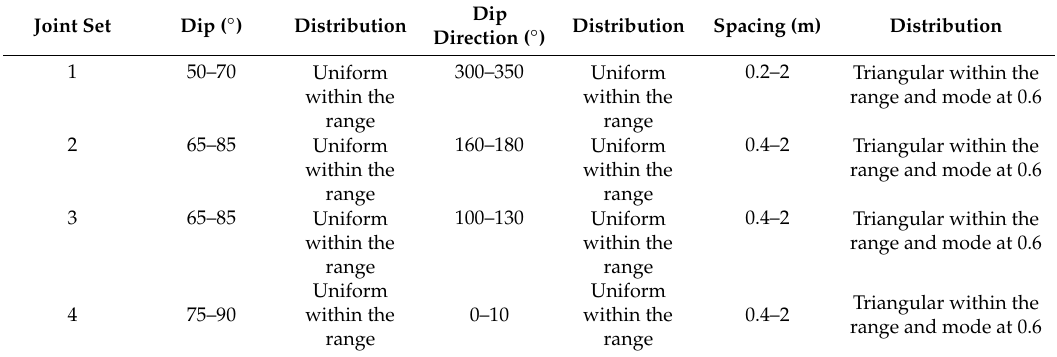
Figure 4. Virtually mapped discontinuity density contours in a stereographic projection ( a ). Major discontinuity sets (average) and distribution of mapped spacing ( b ). Modeled after the work in [35]. Table 1. Joint set data in [35] and probabilistic distribution adopted for the Tornado Mountain